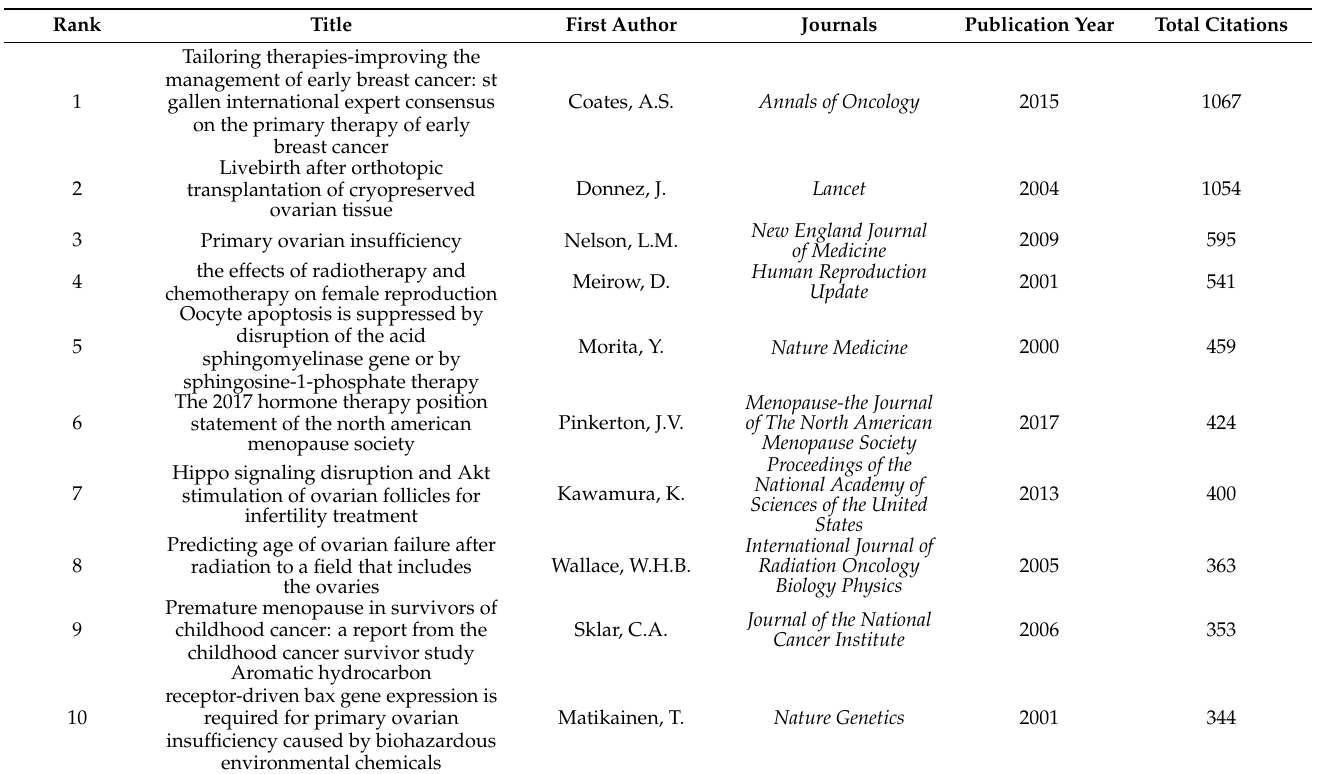
Table 6. Top 10 highly cited documents on therapy for POI from 2000 to 2022.